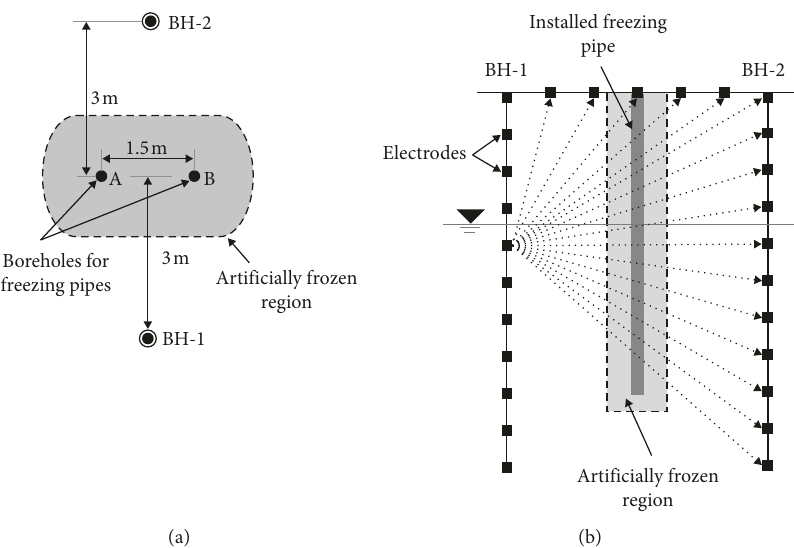
Figure 9: (a) Schematic diagram of the plan and (b) section views of the ground freezing and tomography boreholes.